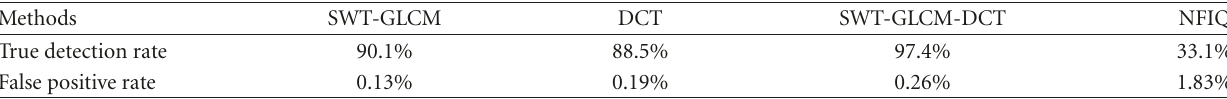
Table 1: Performance comparison of the four methods on 1681 test fingerprint